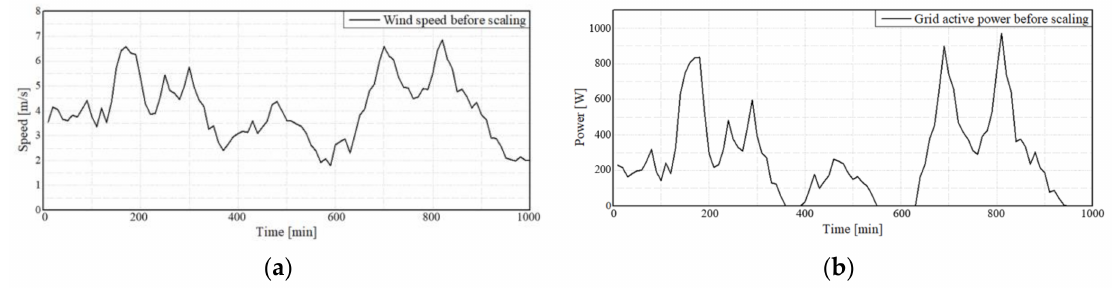
Figure 3. SCADA data for 1000 min: ( a ) the data range of wind speed; ( b ) the range of system active